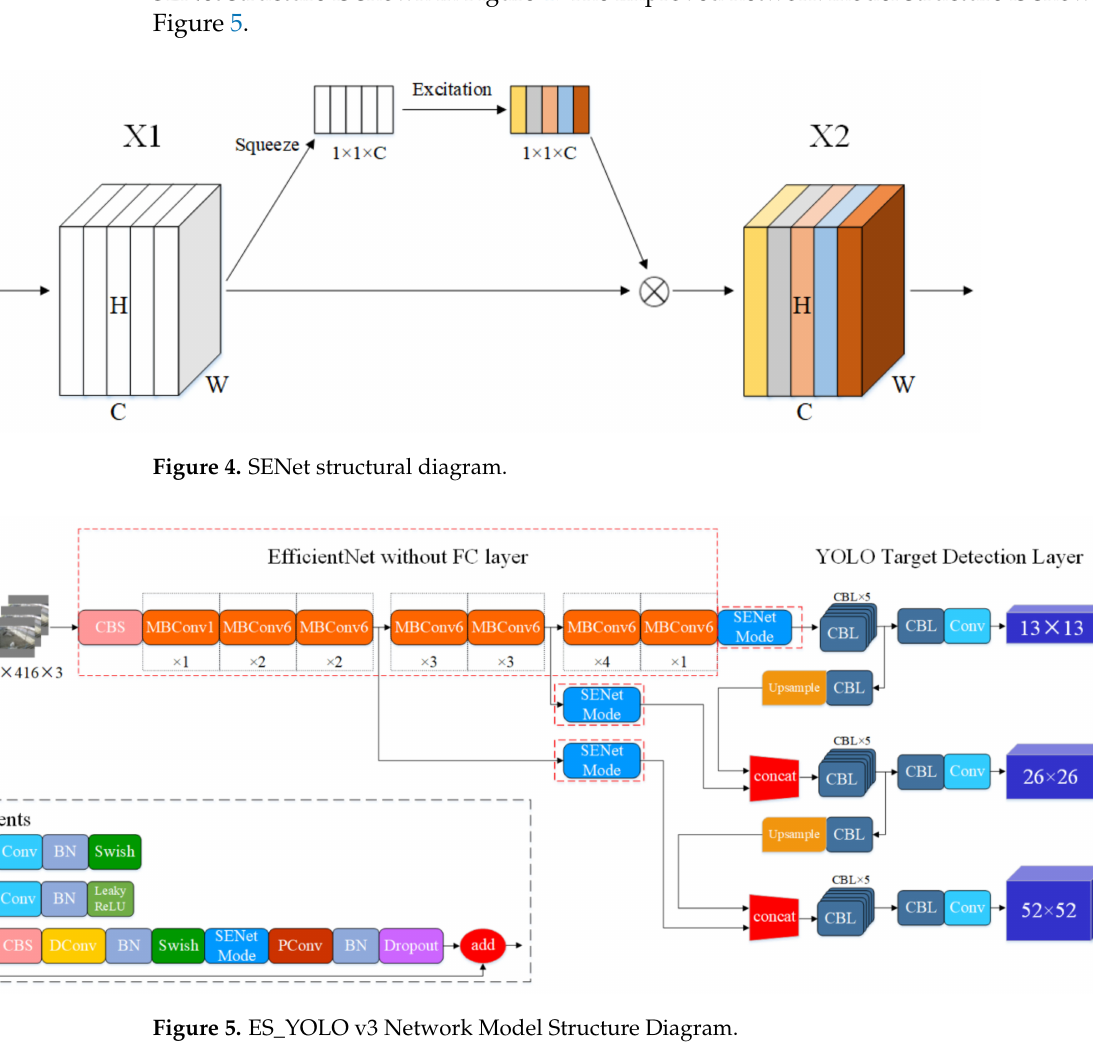
Figure 5. ES_YOLO v3 Network Model Structure